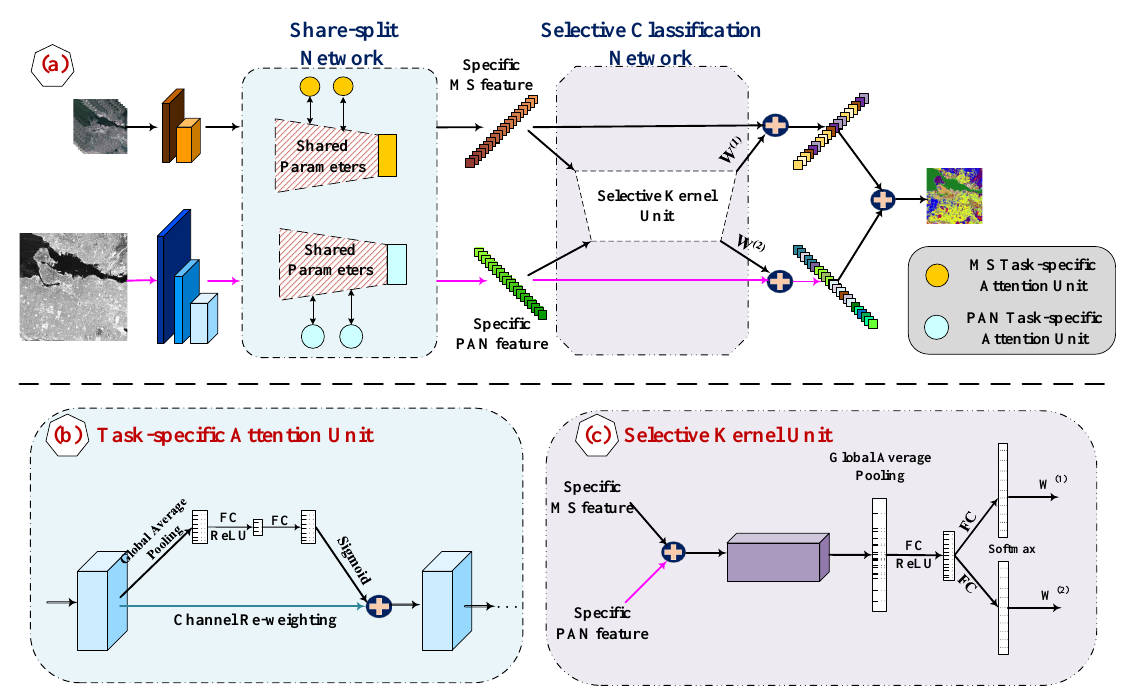
Figure 2. ( a ) The architecture of the proposed attention-guided classification network. In SSNet, the shared branch is designed for extracting basis features of the MS and PAN image, and multiple split branches with MS task-specific attention units and PAN task-specific attention units are designed to capture the specific features of MS and PAN images, respectively. In SCNet, the specific features of MS and PAN images are fused with a selective kernel unit. ( b ) Task-specific attention unit. ( c ) Selective kernel